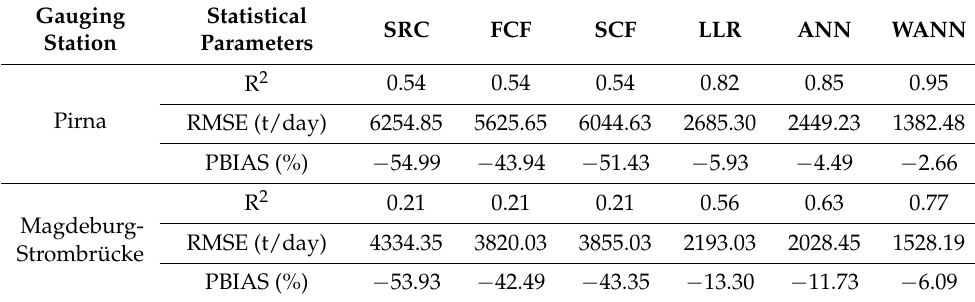
Table 10. A performance comparison among models in capturing peak SSL values.